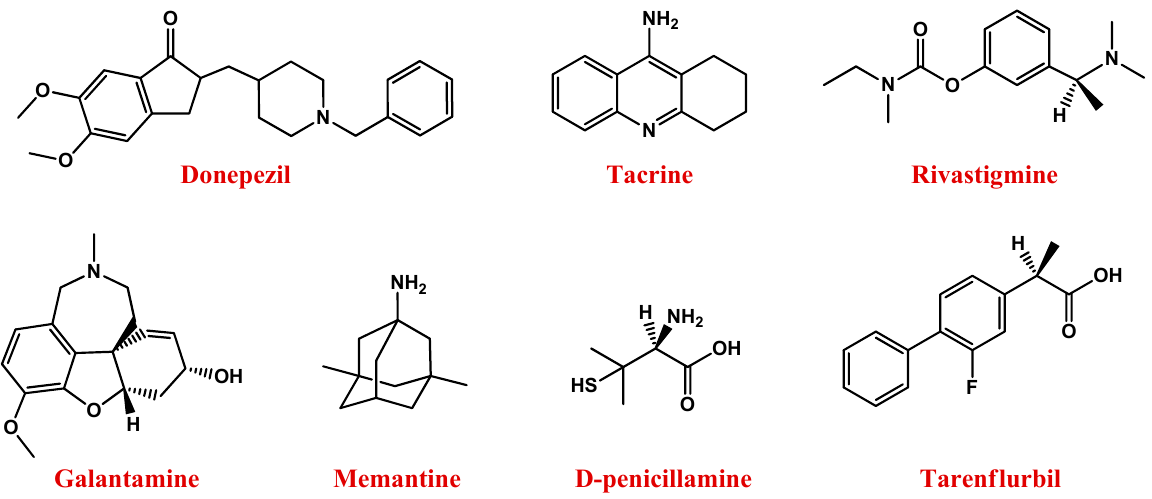
Figure 1. Molecular structures of main anti-AD drugs.